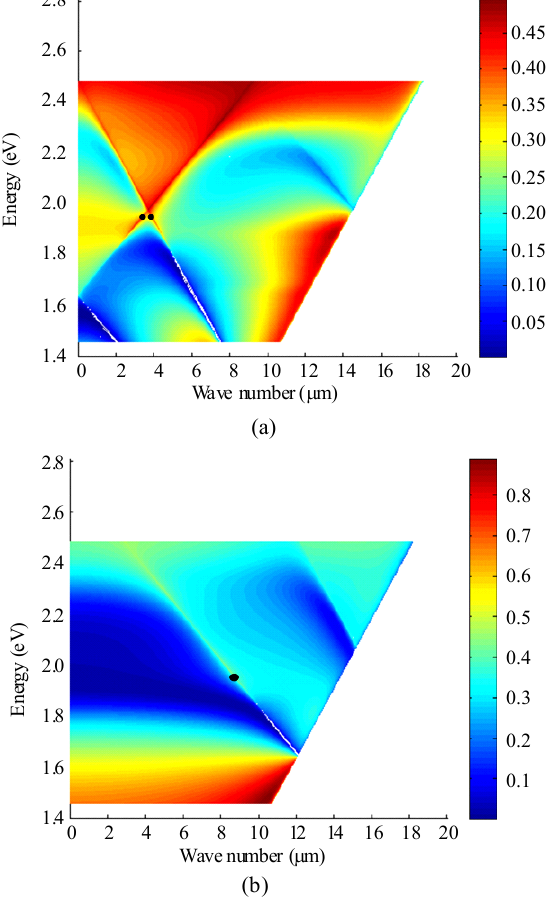
Fig. 8 Transmittance mapping with the dispersion curve obtained using the RCWA method: (a) period of 500 nm and (b) period of 300